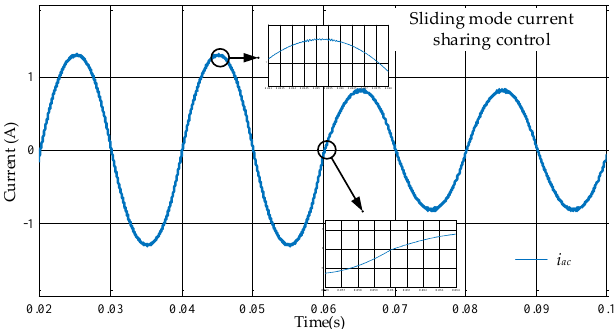
Figure 10. Simulation results of Case 2: output gird current response of interleaved flyback micro-